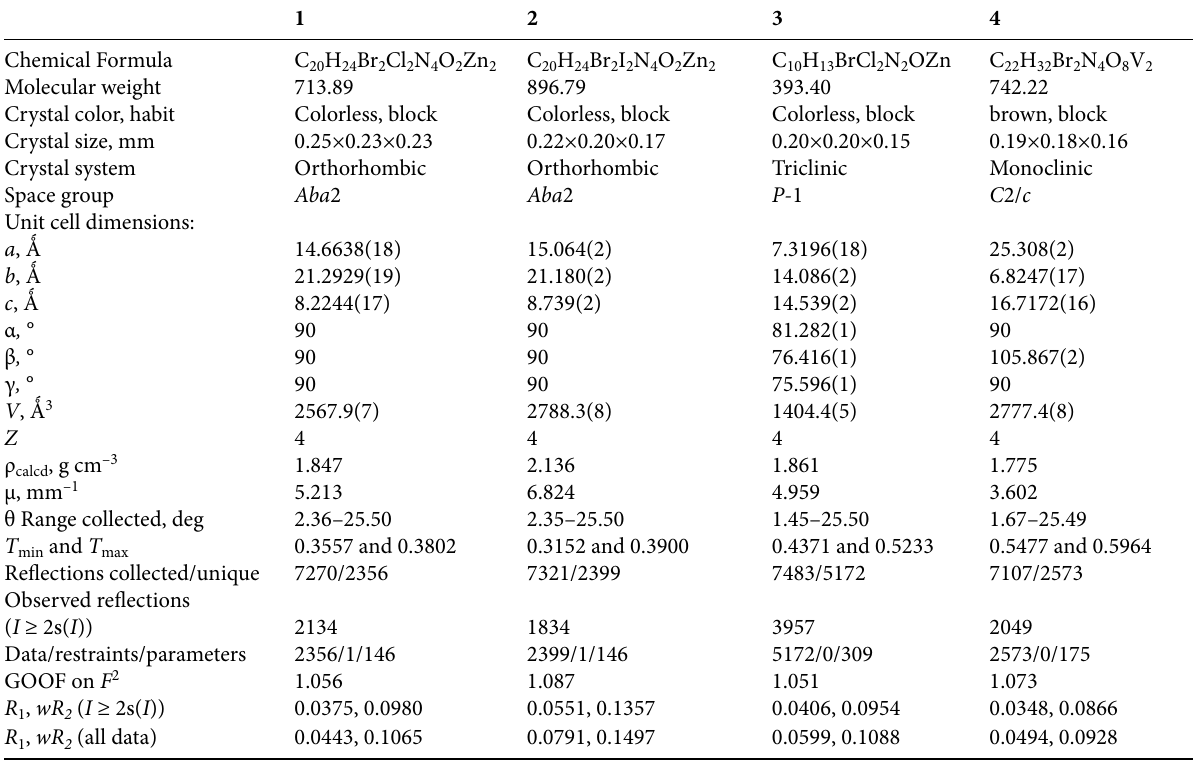
Table 1. Crystallographic data and refinement details for the complexes